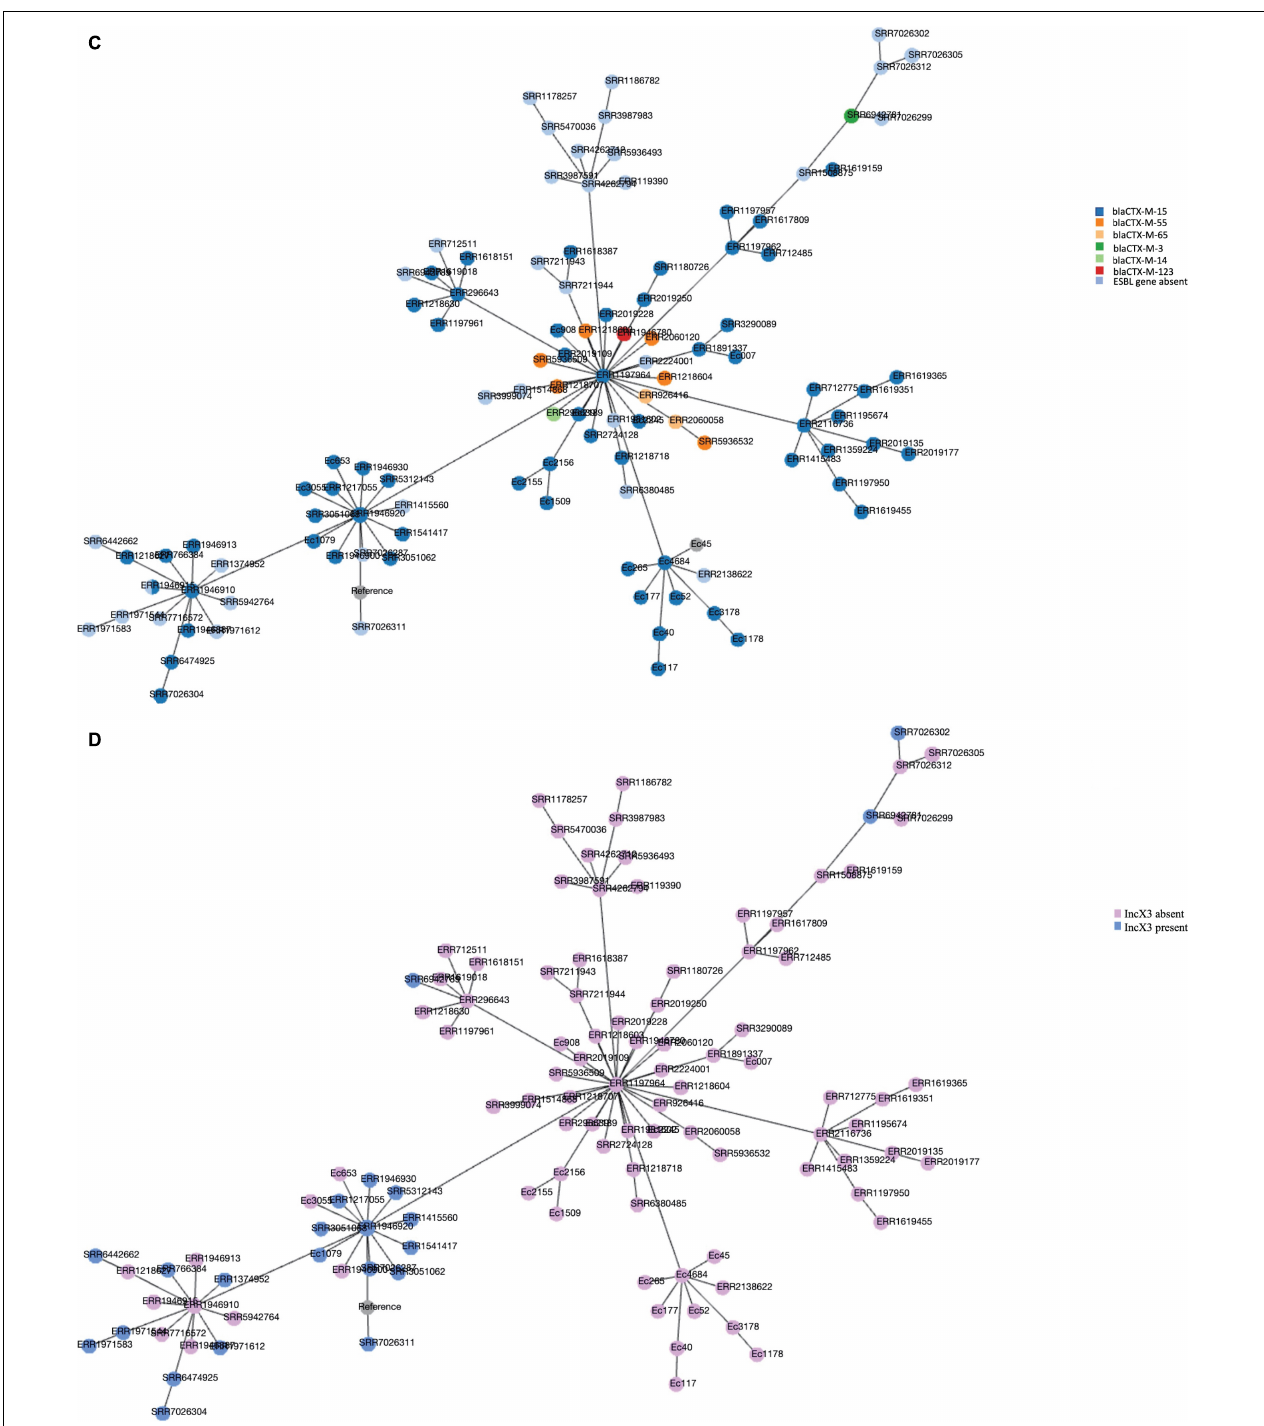
FIGURE 4 | (A) Minimum spanning tree of core-gene alignment of 123 E. coli strains visualized with PHYLOViZ online. Twenty-one Ghanaian strains studied are colored in blue and 102 isolates from global collection are shown in pink color. Strains with similar sequences (Ec54 and Ec52), (Ec56 and Ec40) were represented by one node with slightly increased size. Numbers on the connecting lines denote number of locus variants. (B) Core genome alignment-based minimum spanning tree showing the presence of carbapenemase genes among strains. Gene presence and absence have been indicated by different colors as shown in the legend. Strains with similar sequences as detected by PHYLOviZ were represented by one node with slightly increased size. (C) Core genome alignment-based minimum spanning tree showing the distribution of ESBL genes among strains of various sub-lineages. Different colors depict different genes shown in the figure legend. Strains with similar sequences were represented by one node with slightly increased size. (D) Core genome alignment-based minimum spanning tree showing strains with IncX3 replicon. Strains with similar sequences were represented by one node with slightly increased size.